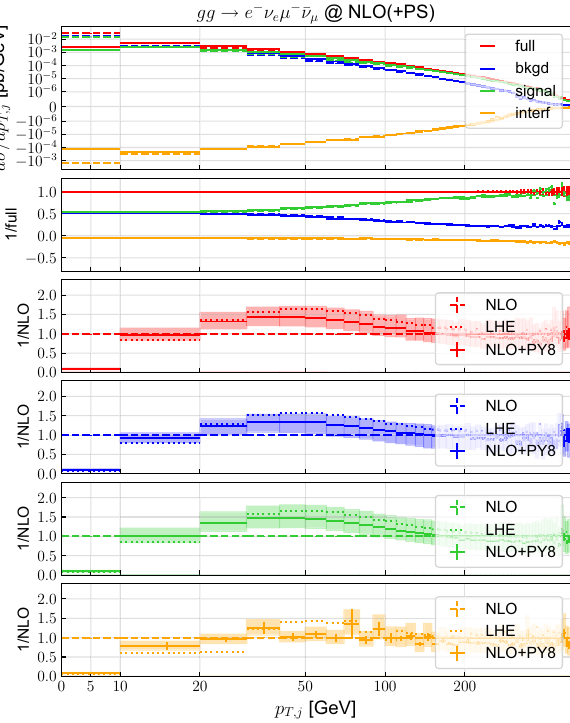
Fig. 9 Differential distribution in the transverse momentum of the four-lepton system p T , 2 (cid:3) 2 ν in gg → e + ν e μ − ¯ ν μ at NLO matched to PYTHIA 8 . Predictions, colour coding and bands as in Fig. 3